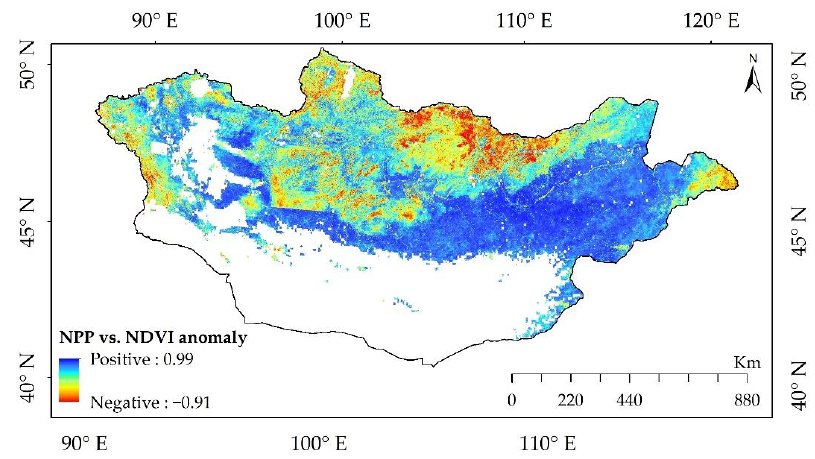
Figure 7. Spatial distribution of correlation coefficient between growing season total NPP and mean NDVI anomaly across Mongolia during 2003–2018.